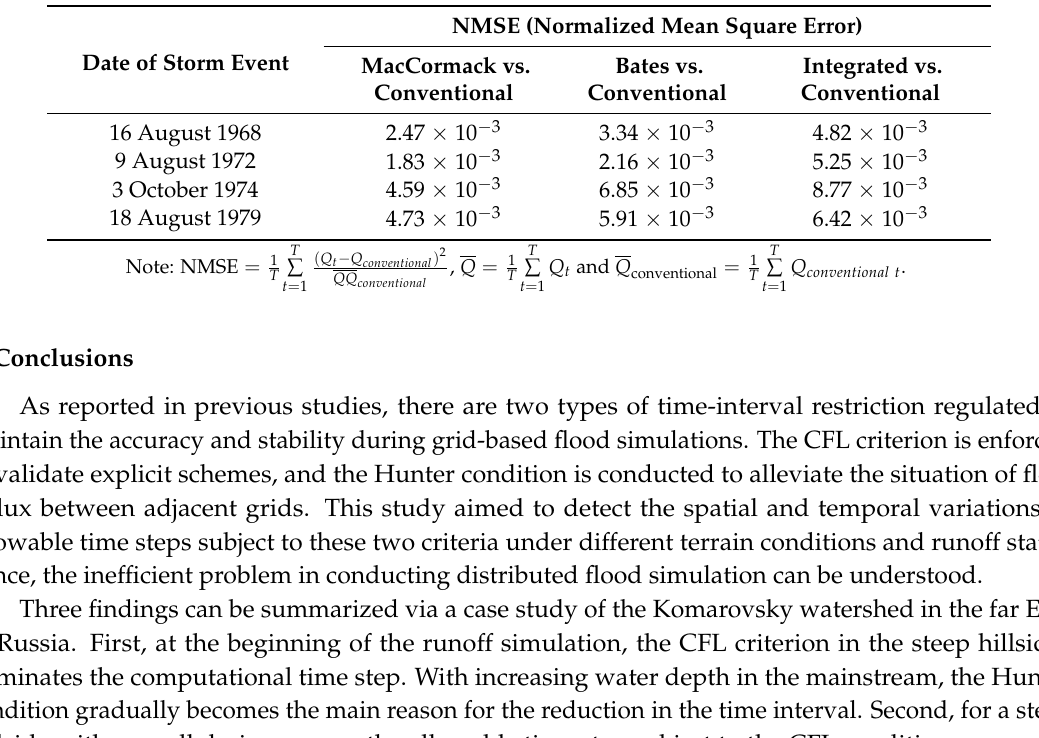
Table 4. Deviation of hydrographs between the conventional and modified